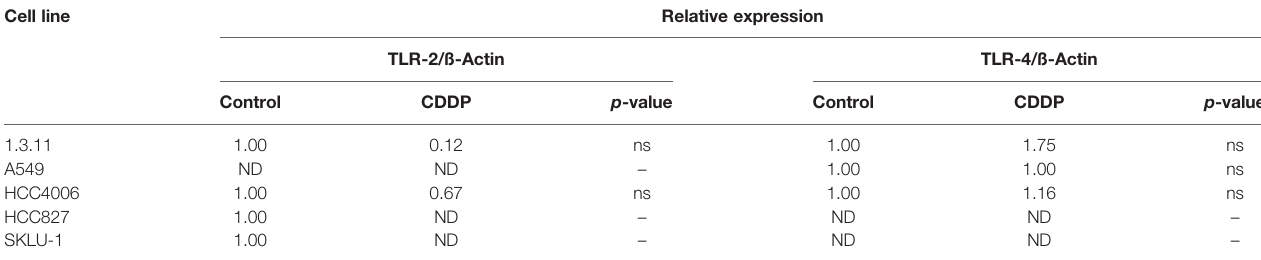
TABLE 4 | TLR-2 and TLR-4 mRNA expression from cultured cell lines. Cell line Relative